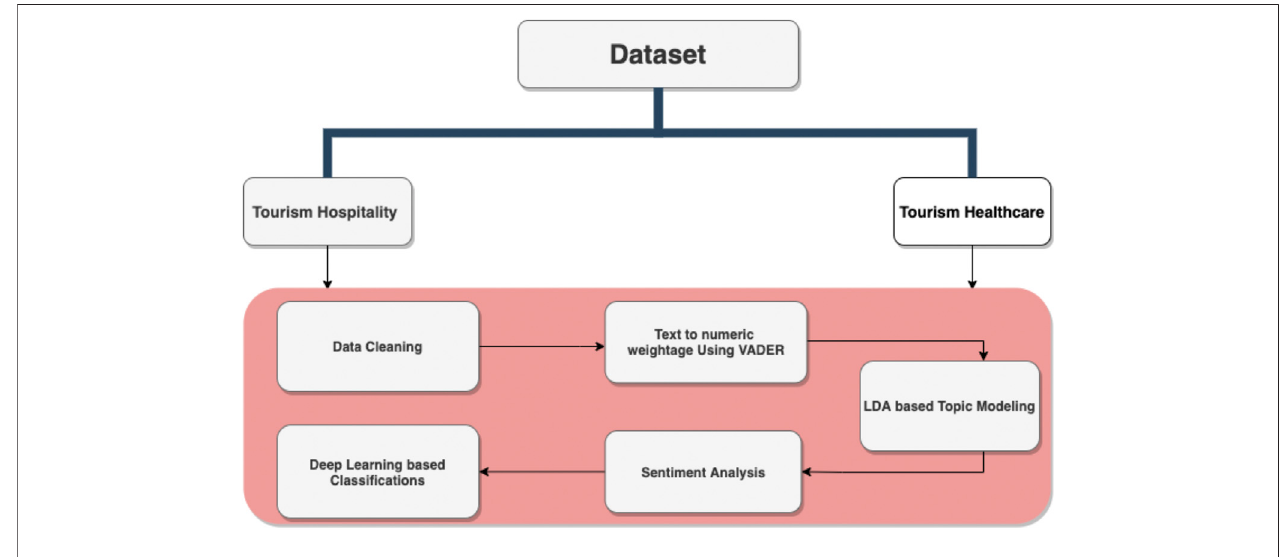
FIGURE 1 | Processing structure.